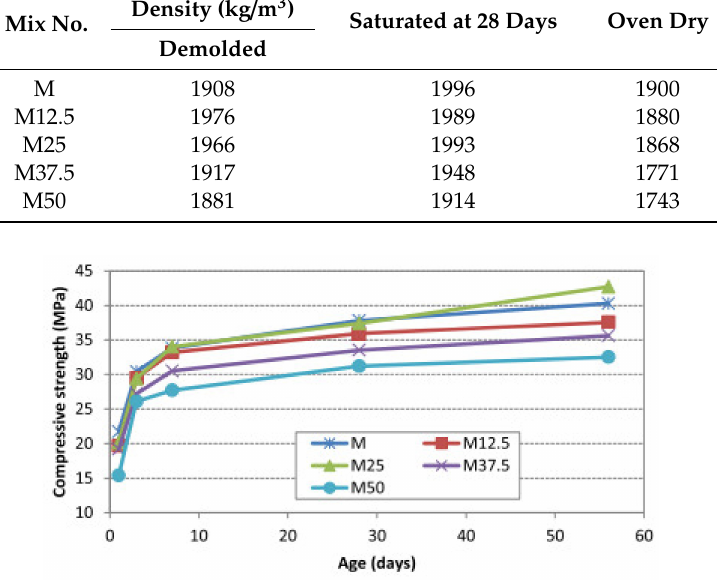
Figure 4. Development of the compressive strength of concrete [50], with copyright permission from Elsevier.